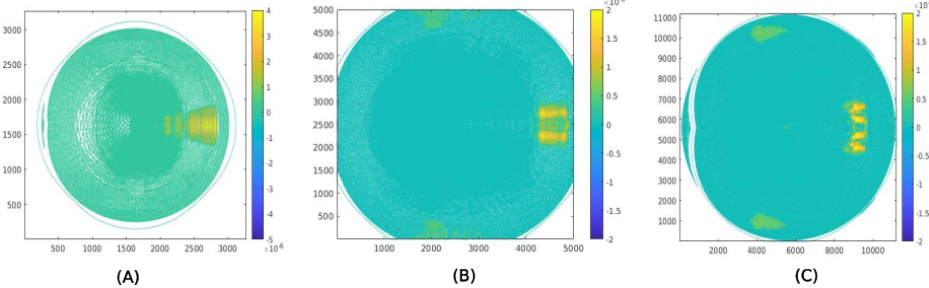
Figure 18. Absolute error between the CPU (double precision in serial) vs. the GPU (single precision) for the parabolic plate experiment at the last Time-step at 2.45 ( A ), 5.00 GHz ( B ), and 20.00 GHz ( C ).